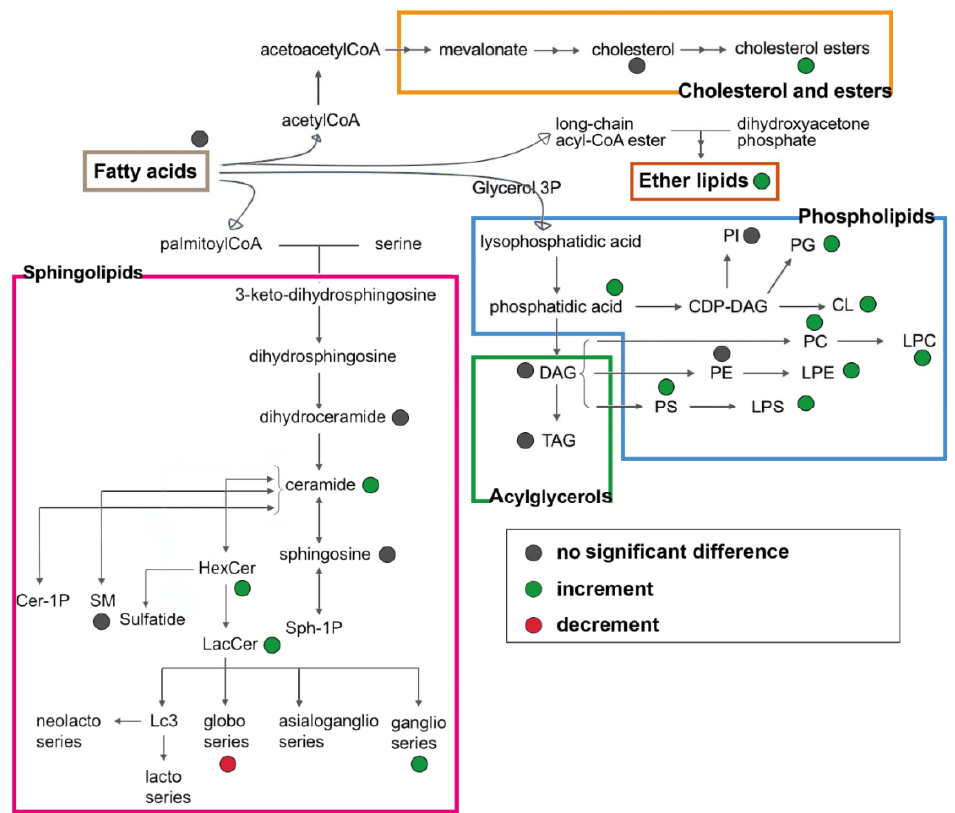
Figure 6. Overview of the lipid biosynthetic and metabolic pathways. Colored dots represented the lipid changes in CF bronchial epithelial cells.